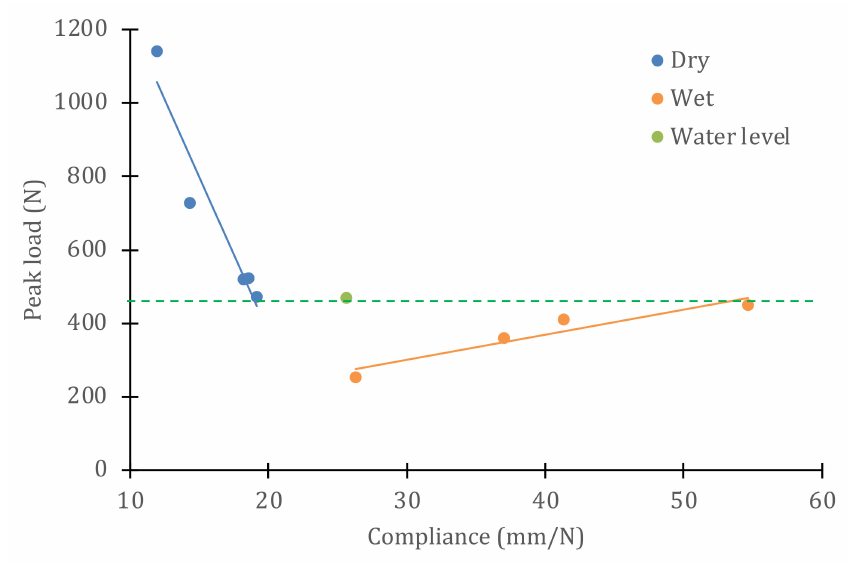
Figure 12. Linear correlation between strength and compliance after cyclic impact, for dry/wet conditions of the